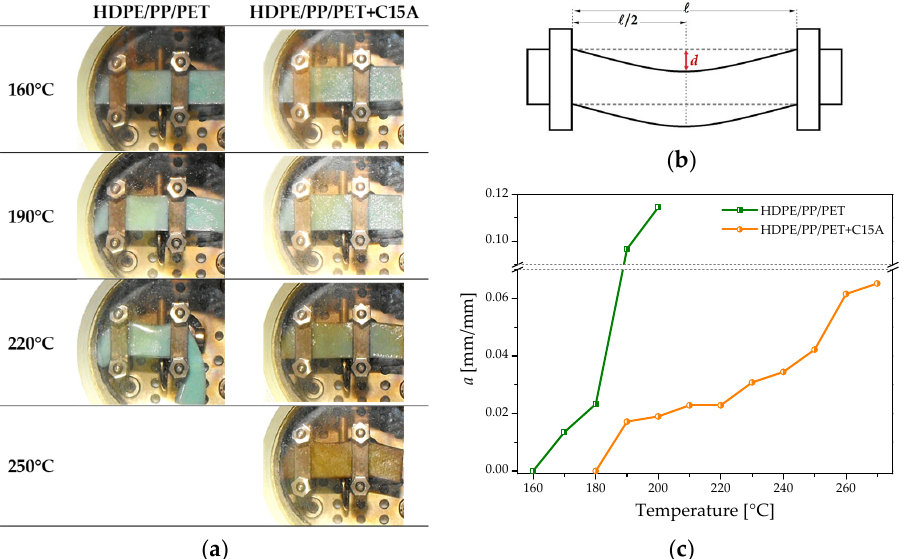
Figure 4. ( a ) Pictures of the specimens taken at different temperatures during the DMA tests. ( b ) Definition of the dimensionless maximum deflection a = d/l . ( c ) Temperature dependence of a for the unfilled and nano-filled blend.